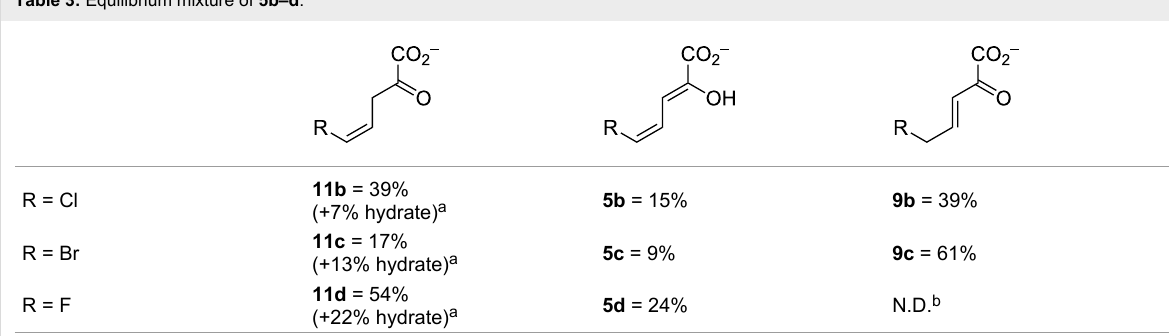
Table 3: Equilibrium mixture of 5b–d